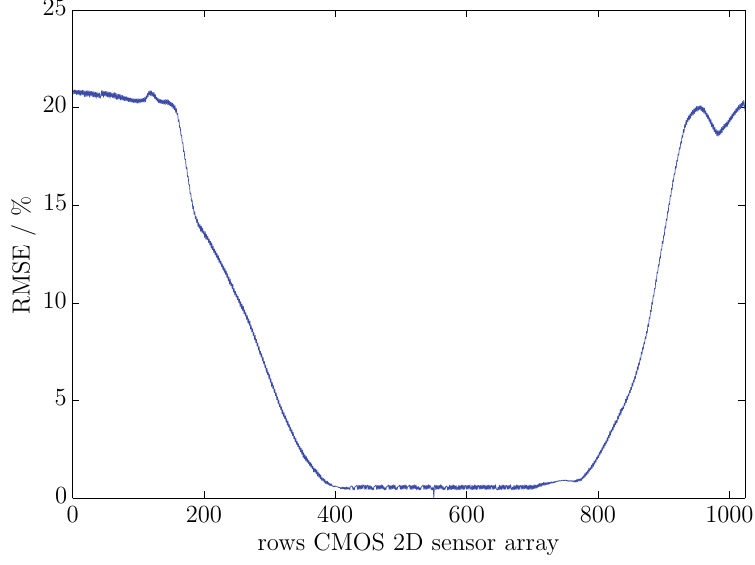
Figure 5. Root-mean-square error (RMSE) trend between a reference row and all other rows of the CMOS 2D sensor array. The chosen rows (row number 400 to 700) show a maximal RMSE of 0 . 65 % to the reference row (row number: 442).